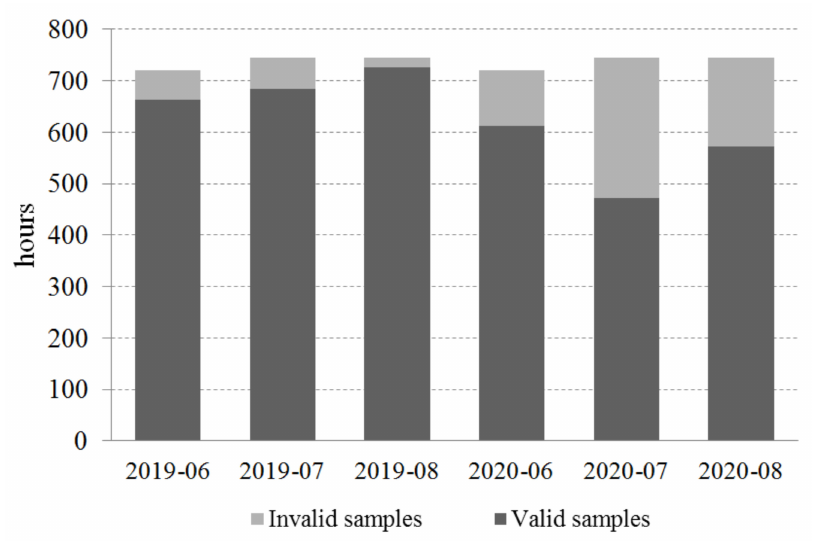
Figure 2. The number (unit: hours) of valid samples and invalid samples in the summer (June, July, and August) during 2019–2020. Valid samples are defined as data that are present in both the AWS and radar QPE data for each hour. Otherwise, the sample was determined to be invalid otherwise and could not be used in the